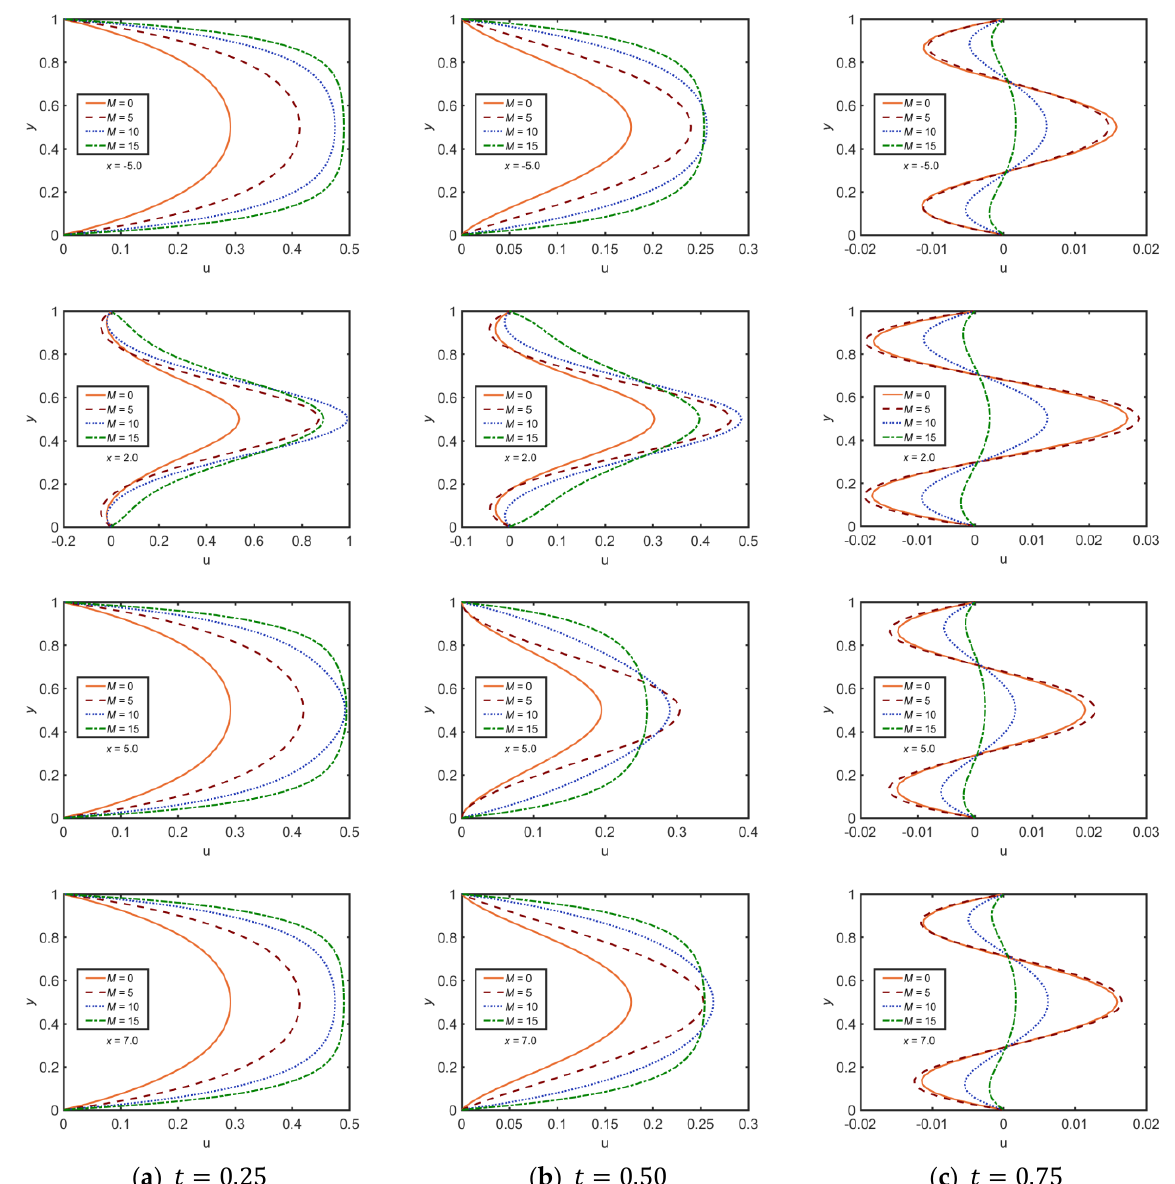
Figure 8. u profiles of the pulsatile flow at different instants of a pulsation cycle for different values of M at various locations. x